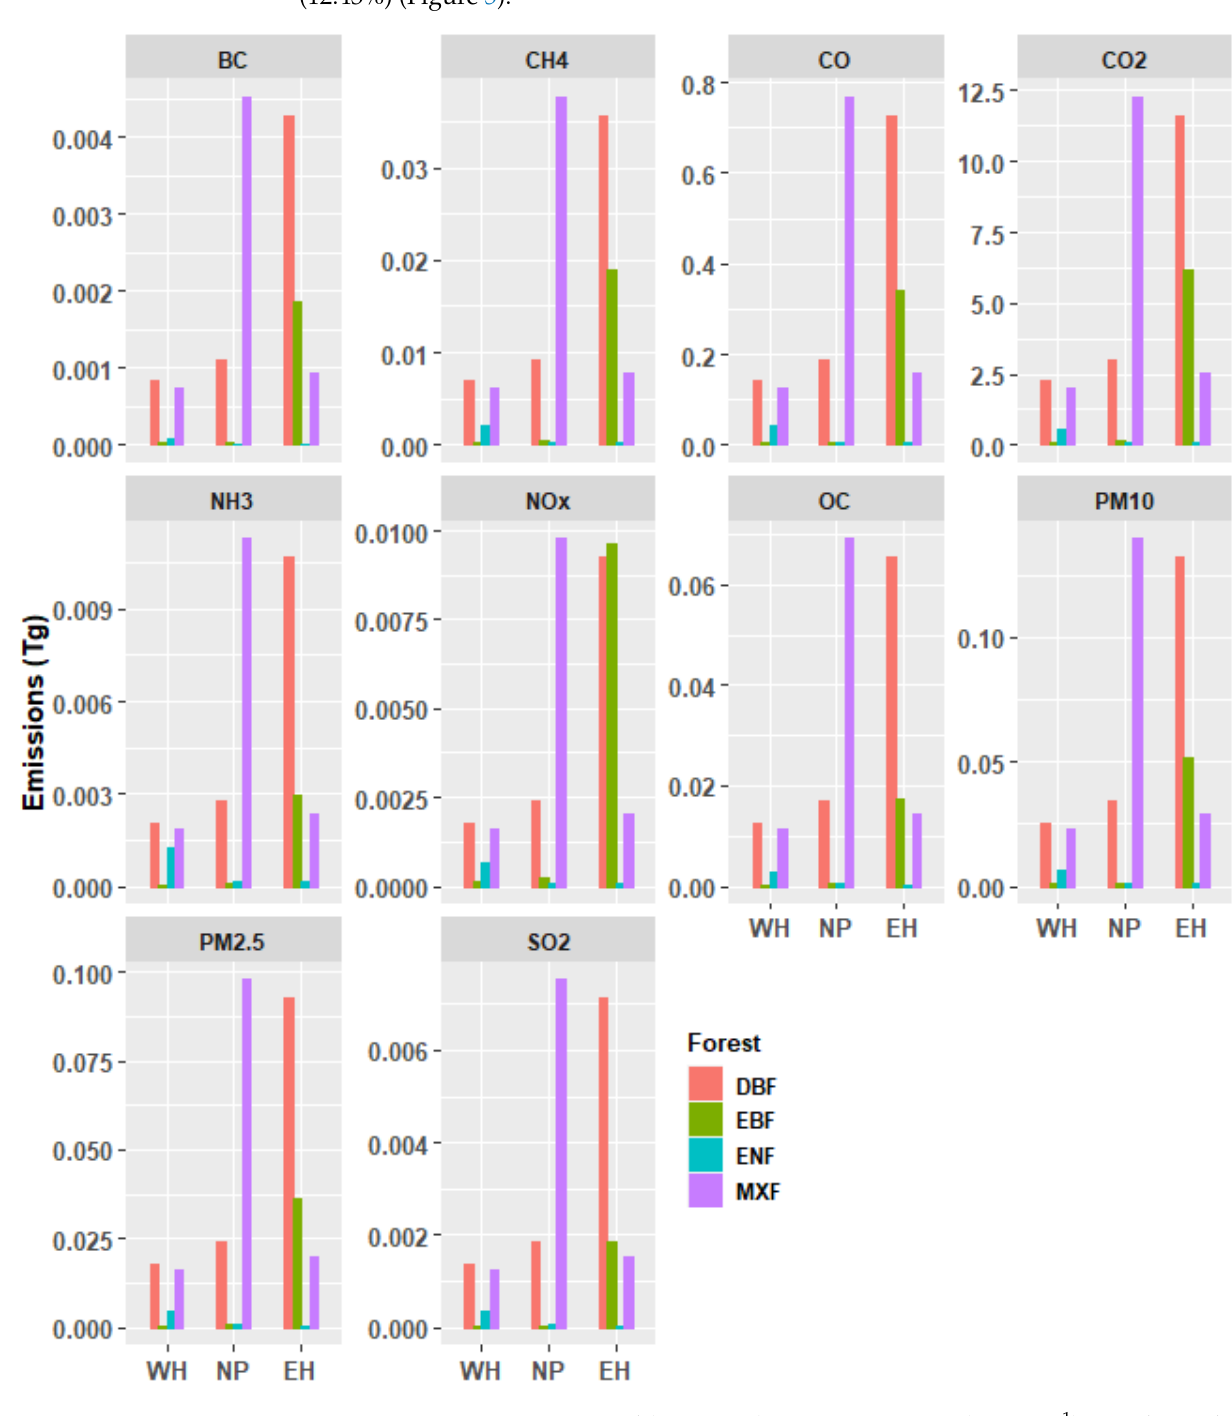
Figure 5. Forest type-wise annual (2001–2020) average emissions (Tg year − 1 ) over the study area (WH: Western Himalaya, NP: Nepal, and EH: Eastern Himalaya).